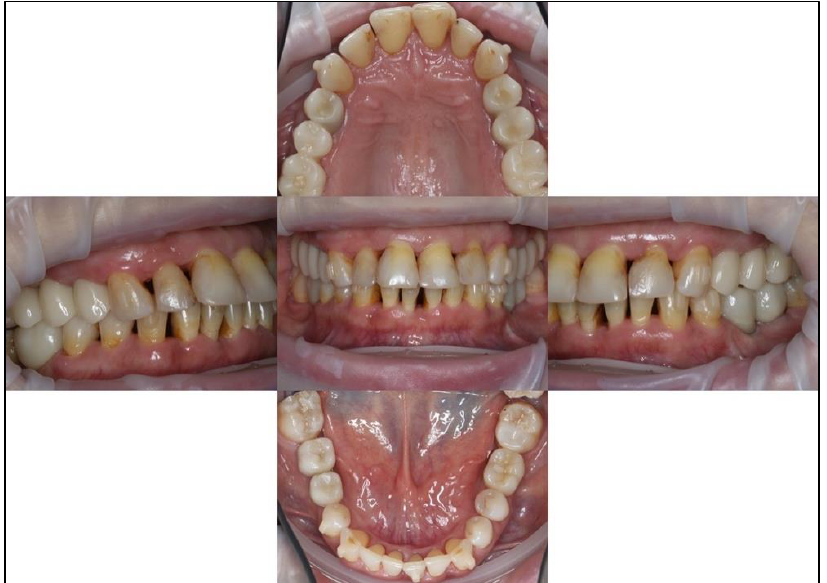
Figure 17. Intraoral pictures with temporary crowns .